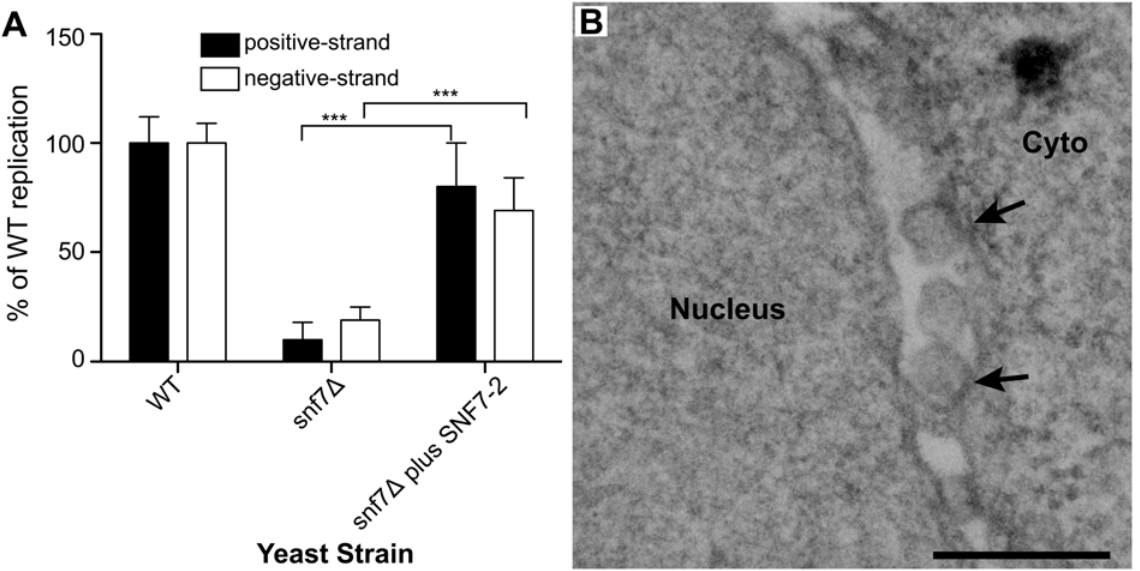
Fig 7. Plant homolog of Snf7p complements BMV RNA replication and spherule formation in yeast. (A) Positive-strand RNA4 and negative-strand RNA3 accumulation in snf7 Δ yeast expressing 1a, 2a pol , RNA3 and either an empty plasmid or AtSNF7 – 2, the Arabidopsis thaliana homolog of yeast Snf7p, was measured by Northern blotting. Values represent the mean and standard deviation of three independent experiments. *** p < 0.001. (B) Representative EM image of snf7 Δ yeast expressing 1a, 2a pol , RNA3 and AtSNF7 – 2. Scale bar: 200 nm.